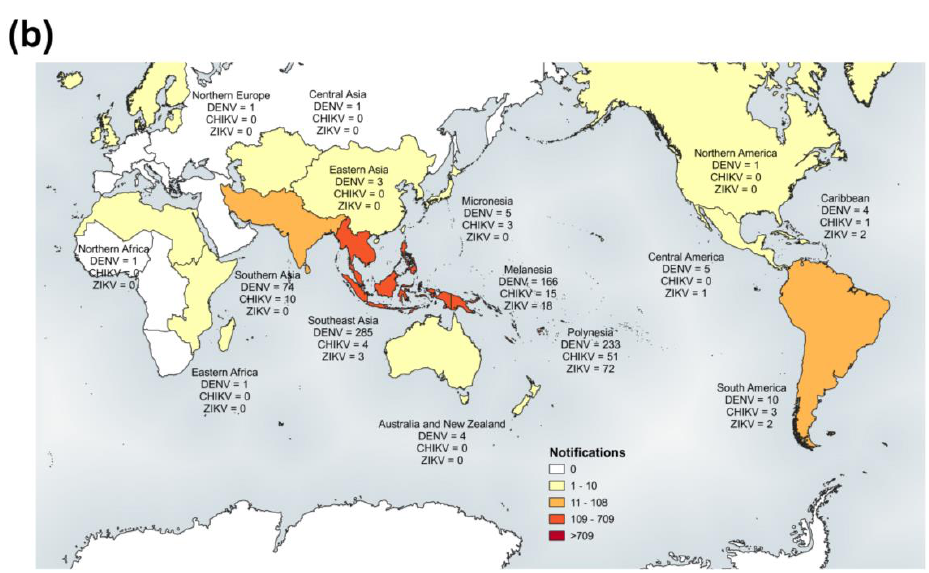
Figure 8. Notified cases among travellers to NZ by location of embarkation, 2008 – 2017. Subregional classifications were taken from the United Nations Statistics Division at https://unstats.un.org/unsd/methodology/m49/. ( a ) Number of notified confirmed DENV1 – 4, CHIKV, and ZIKV cases reported in NZ among travellers returning from the identified embarkation locations, 2008 – 2017 [70]. Specific locations or broader regional classifications were dependent on the travel history information available. All cases had travelled overseas. ( b ) Choropleth map of the number of positive notifications reported by ESR (2008 – 2017) based on subregional classifications.